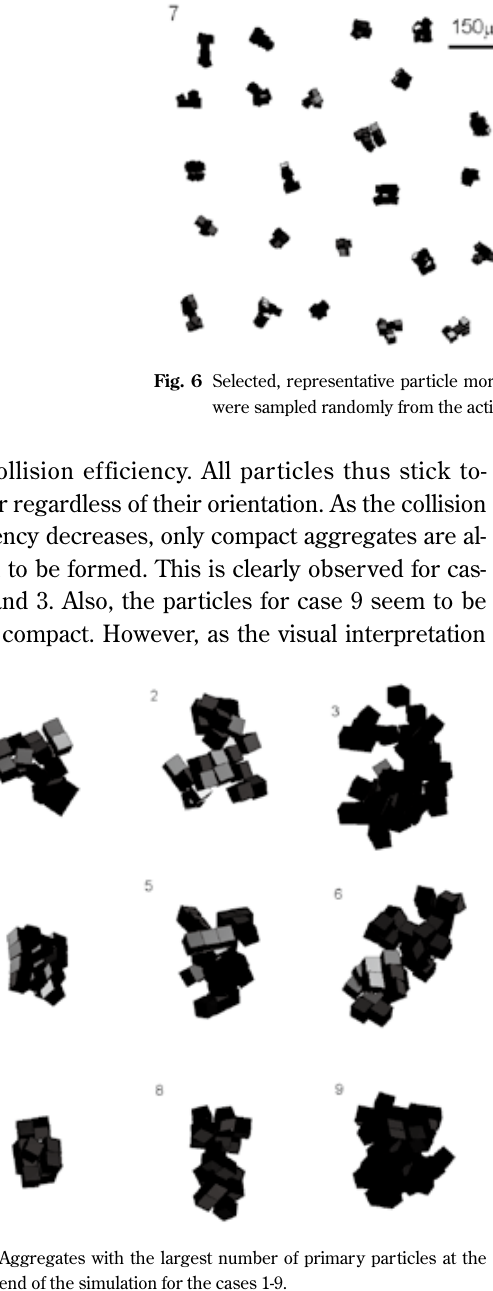
Fig. 7 Aggregates with the largest number of primary particles at the end of the simulation for the cases 1-9.